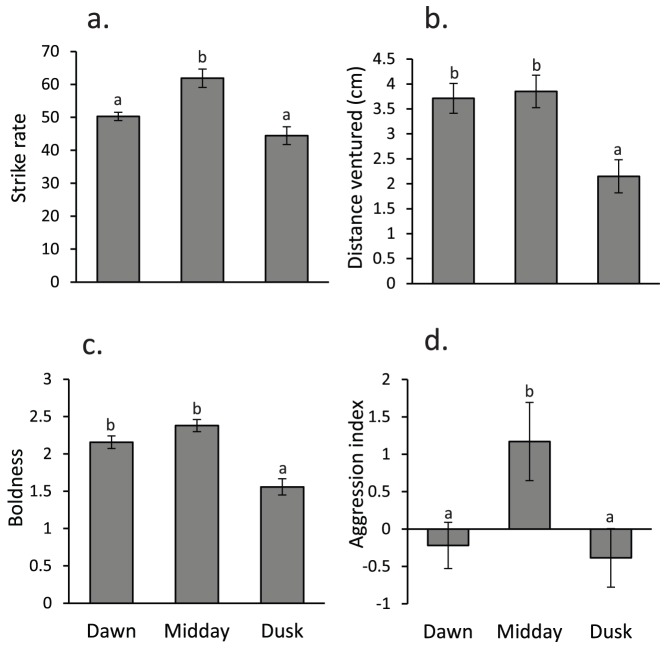
Mean (± SE) behaviour of juvenile Pomacentrus moluccensis at three times of the day: dawn, midday and dusk.a) Strike rate per 3 min focal observation, b) relative horizontal distance from coral patch (cm), c) boldness (a value of 0 represents a shy individual, 3 very bold), d) aggression index (the larger the value, the more aggressive). Letters above bars represent Tukey's HSD homogenous subsets of means (p < 0.05 for subsets to differ). N  =  32, 29, 26 (dawn, midday and dusk respectively).